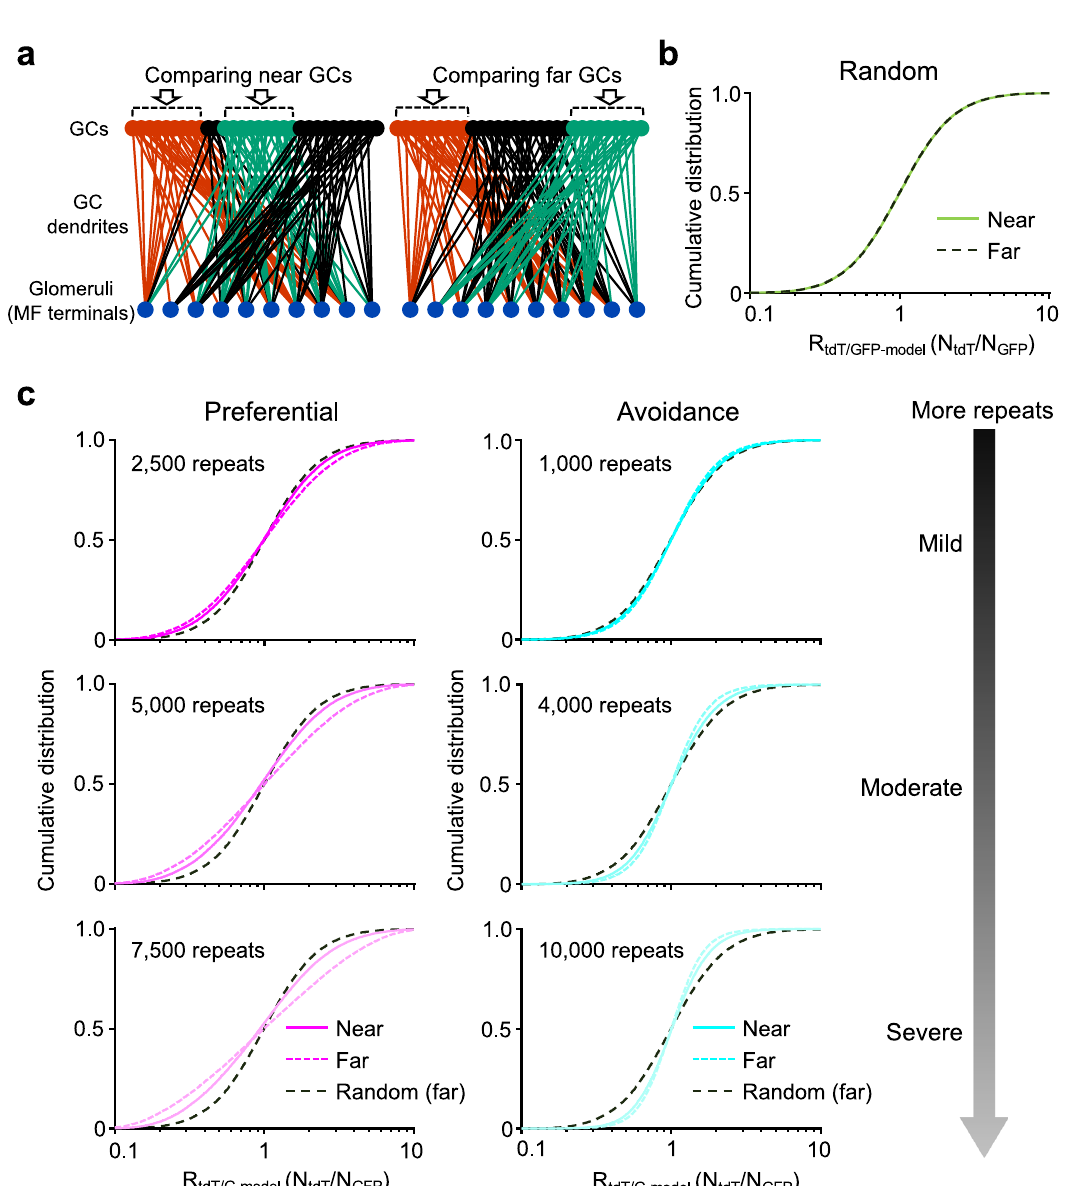
Fig. 5 Properties of synaptic connections in the network model. a Diagrams showing the location of two groups of GCs located at near (left, near GCs) or far (right, far GCs) distance in the network model. To see how the distance of two groups of GCs affects the R tdT/G distributions ( b , c ), R tdT/G-model values were calculated by assuming that either far GCs or near GCs were labeled. b The overlapping cumulative distributions of R tdT/G-model calculated using near (solid green line) and far (dotted dark brown line) GCs in the random connection model. c The cumulative distributions of R tdT/G-model in the different levels of preferential (left) or avoidance (right) connection models. When the permutation trials were repeated more, as indicated in the panels, the levels of preferential or avoidance connection became severer. R tdT/G-model calculated using near (solid lines) and far (dotted lines) GCs are overlaid together with the result in random connection model (dotted dark brown lines). The x-axis is in log scale. COMMUNICATIONS BIOLOGY| (2023) 6:446